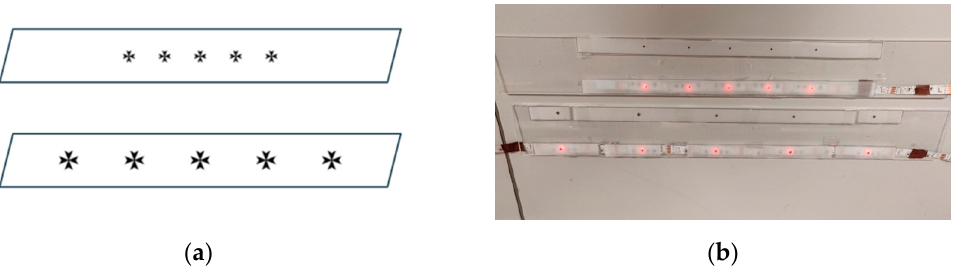
Figure 2. Methacrylate accessory plates: ( a ) Superior plate presenting the stimuli for 5 D of accom- modative demand and inferior plate presenting the stimuli for 2.5 D of accommodative demand; ( b ) Final accessory plates with an identical second set of red LED backlighted stimuli for each accom- modative distance.